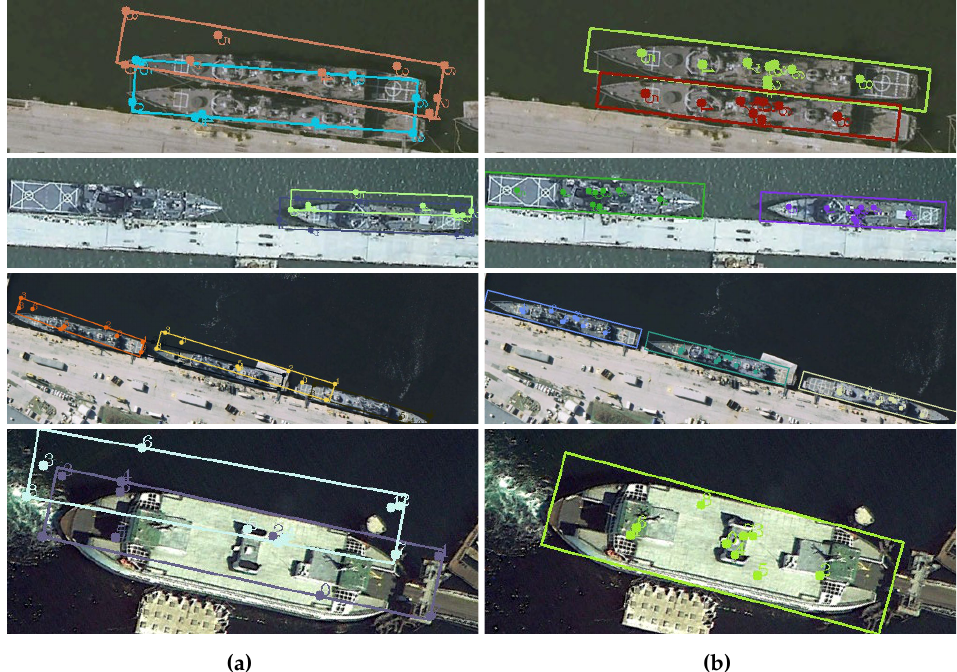
Figure 4. Comparison of the visualization results of PointSet and G-Rep on HRSC2016 dataset. ( a ) PointSet. ( b )